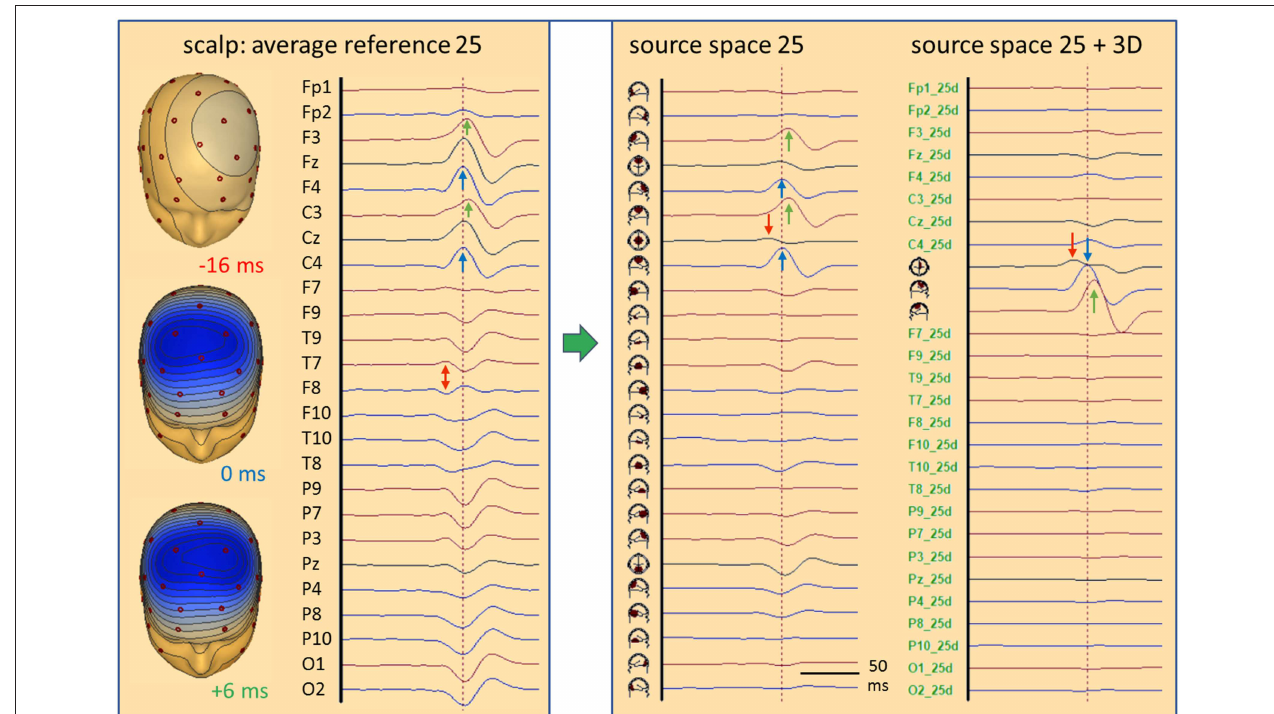
FIGURE 6 | Standard source space 25. In the simulated case of a propagating frontal IED (cf. Figure 5 ), transformation from scalp ( left ) into source space ( right ) is illustrated. The same sequence of channels from Fp1 to O2 is used to compare the scalp potential with the radial current below each electrode (source space 25). Source channels F9–10 and T9–10 have specific orientations (see text). Time scale is expanded to visualize the different latencies; amplitude scales are relative to enable comparison. The weak onset activity of CG (red arrows, − 16ms) is barely seen on the scalp, but has an oblique dipolar map. Peak latencies appear earlier in the right frontal-central channels F4 and C4 (blue, 0ms) than left F3 and C3 (green, 6ms). In source space 25, the activity appears more focused to the frontal-central region with much less cross-talk to other regions. The superficial right and left frontal activities appear better separated (blue, green). On the right, source space 25 + 3D shows the combination of the 3 simulated source dipoles with the 25 standard regional sources. This isolates the IED and the flat signals of the 25 standard regions document that they are not involved in the averaged IED. The near-to-tangential onset (red arrow) is seen more clearly now as compared to source space 25. For more details see